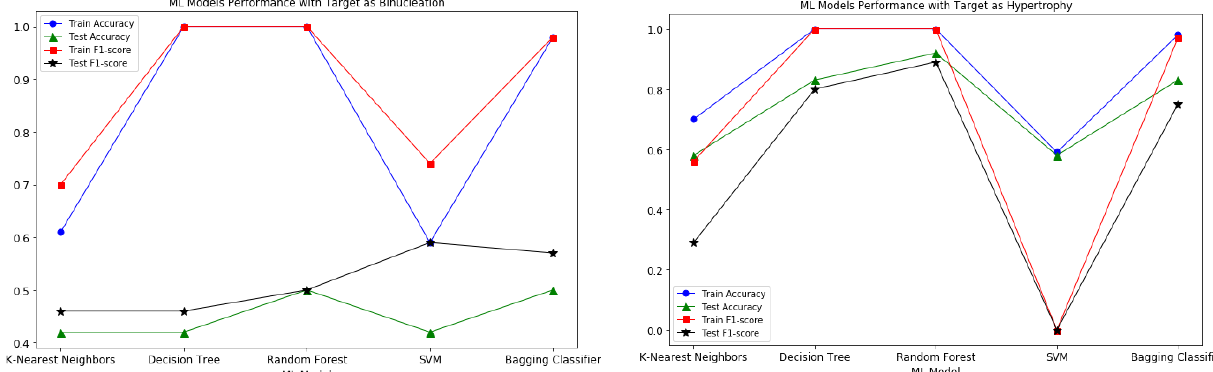
Figure 4. Model Performance metrics comparison plots for both the target variables with K-Nearest Neighbors, Decision Tree, Random Forest, SVM and Bagging Classifier Models. Table 4. Bagging Classifier Performance Results (* Binucleated cells number per mm 2 of tissue). Target Variable